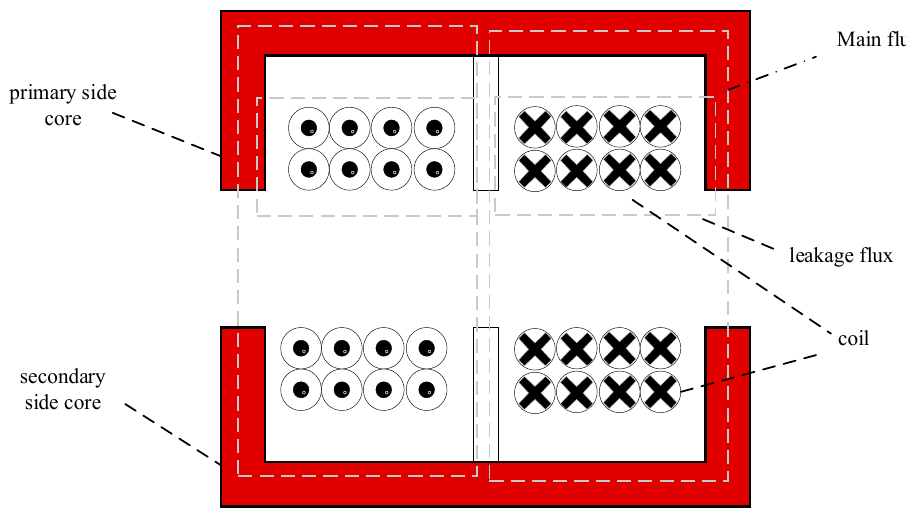
Figure 3. Porcelain tank transformer structure.